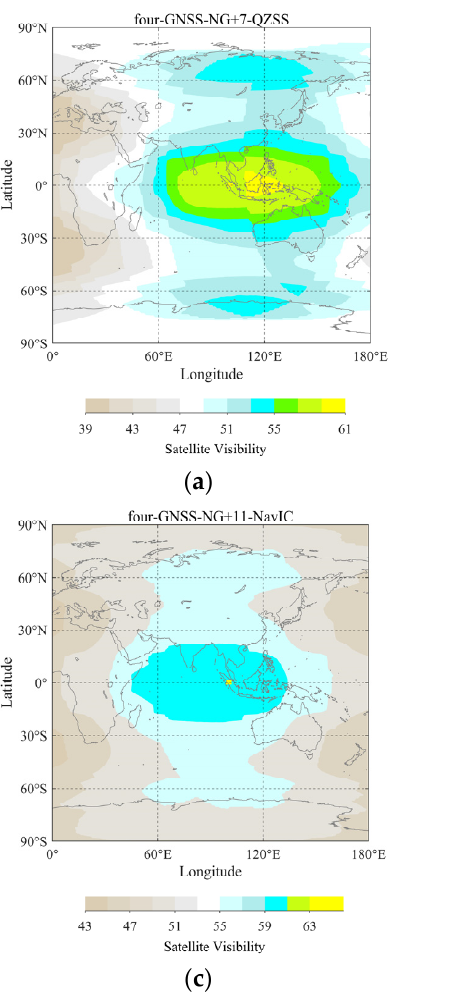
Figure 13. Satellite visibility and GDOP of the four-GNSS-NG+7-QZSS and the four-GNSS-NG+11-NavIC: ( a ) visible satellites of the four-GNSS-NG+7-QZSS; ( b ) GDOP of the four-GNSS-NG+7-QZSS; ( c ) visible satellites of the four-GNSS-NG+11-NavIC; ( d ) GDOP of the four-GNSS-NG+11-NavIC.